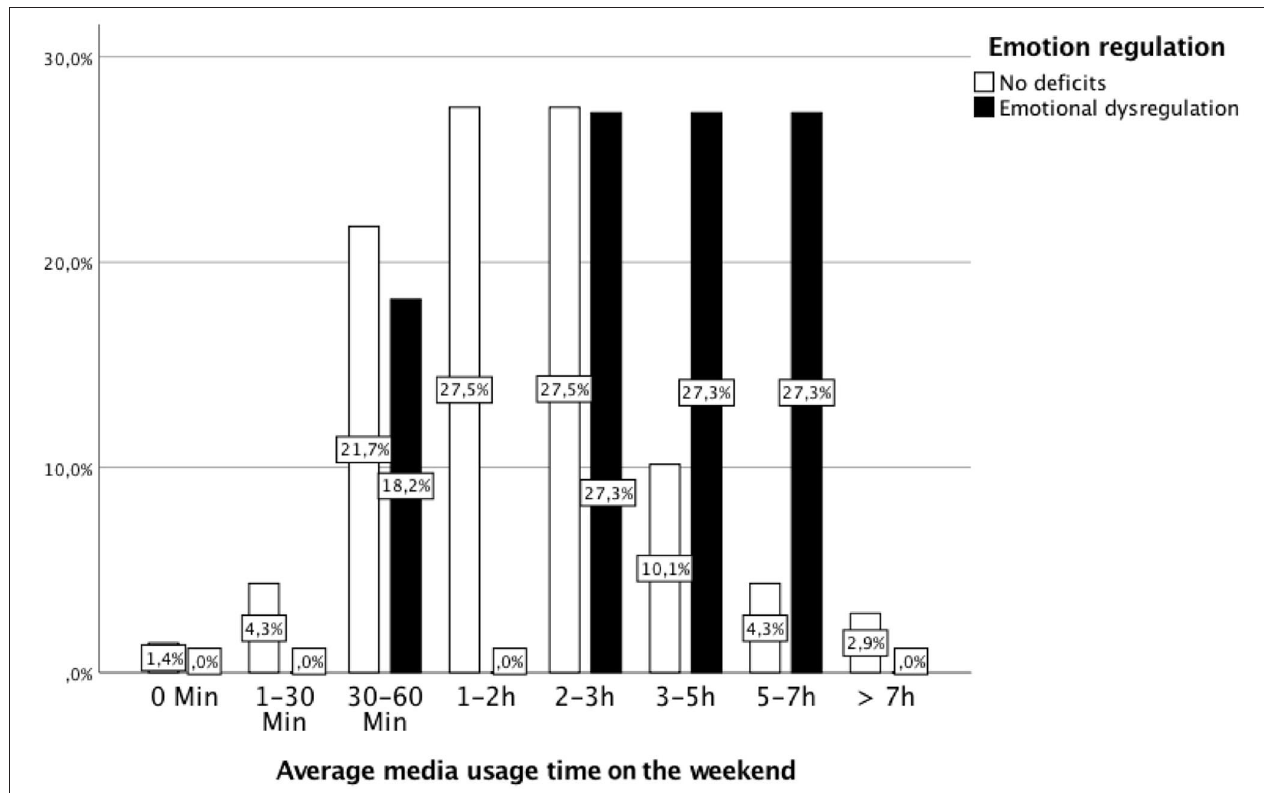
FIGURE 2 | Daily average media usage time at the weekend by children with ED and without ED. Children with ED used media significantly longer at weekends than children without ED (Mann–Whitney U -test: M rank with ED = 55.50, M rank without ED = 38.11; U = 214.5, Z = − 2.36, p < 0.018).